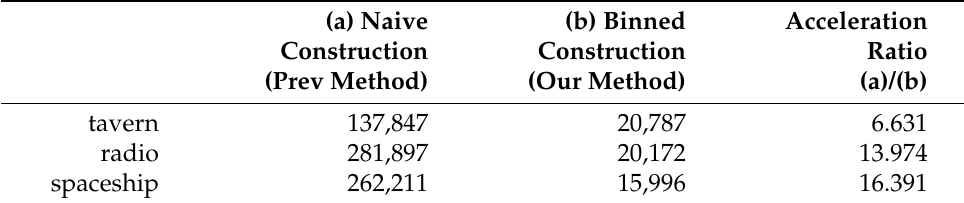
Table 1. The BVH tree construction performance for three different models (unit: µ sec).